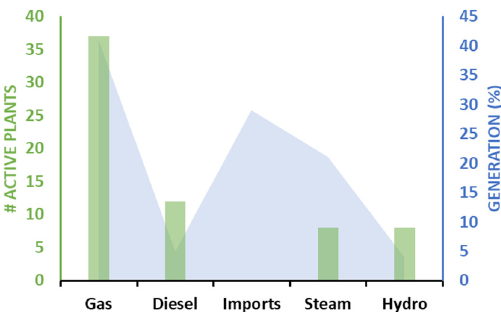
Figure 3. Number of energy stations and their generation rates in Iraq (data extracted from [28]).